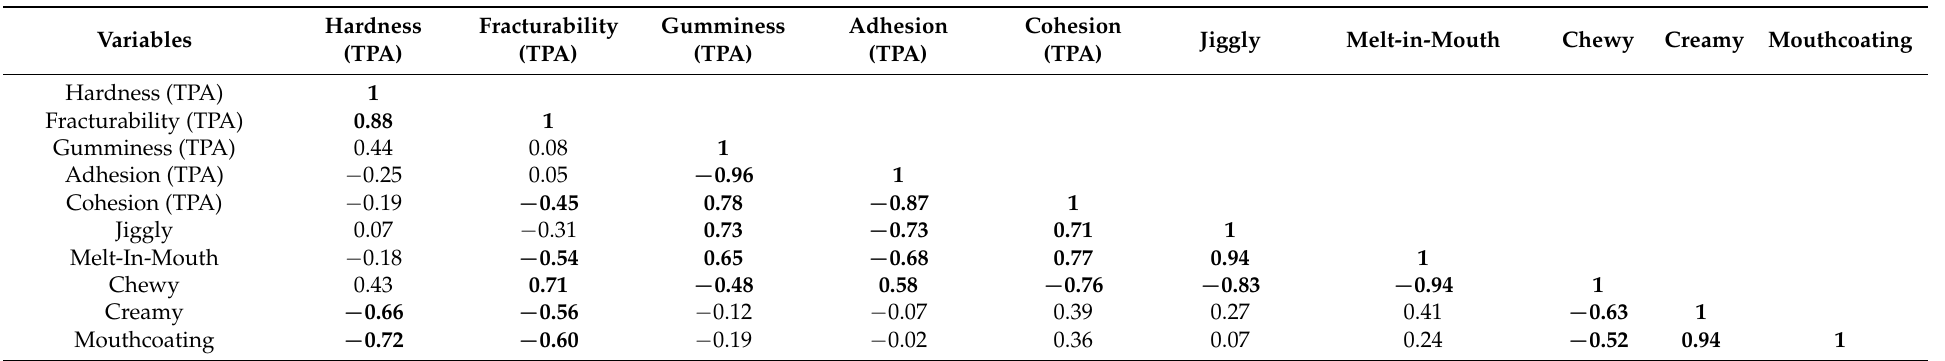
Table 3. Correlation matrix of the mean sensory textural ratings and instrumental measurements across samples. Values in bold are different from 0 with a significance level α = 0.05. TPA = texture profile